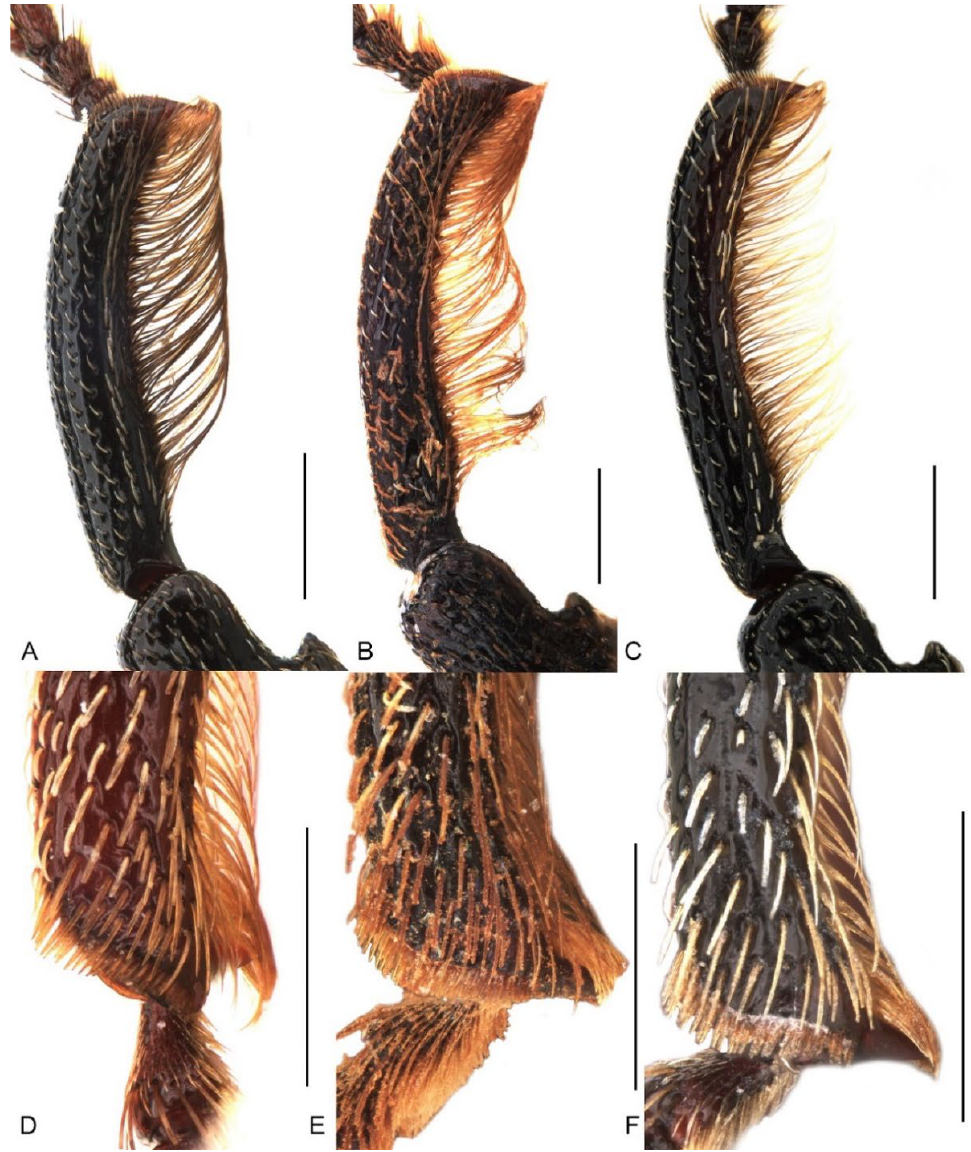
Figure 6. Diagnostic external characters of Miltotranes : ( A ) M. prosternalis , left protibia of male, dorsal view; ( B ) M. subopacus , ditto; ( C ) M. wilsoni sp. n., ditto; ( D ) M. prosternalis , left mesotibia of male, dorsal view; ( E ) M. subopacus , ditto; ( F ) M. wilsoni sp. n., ditto. Scale bars: 0.5 mm.